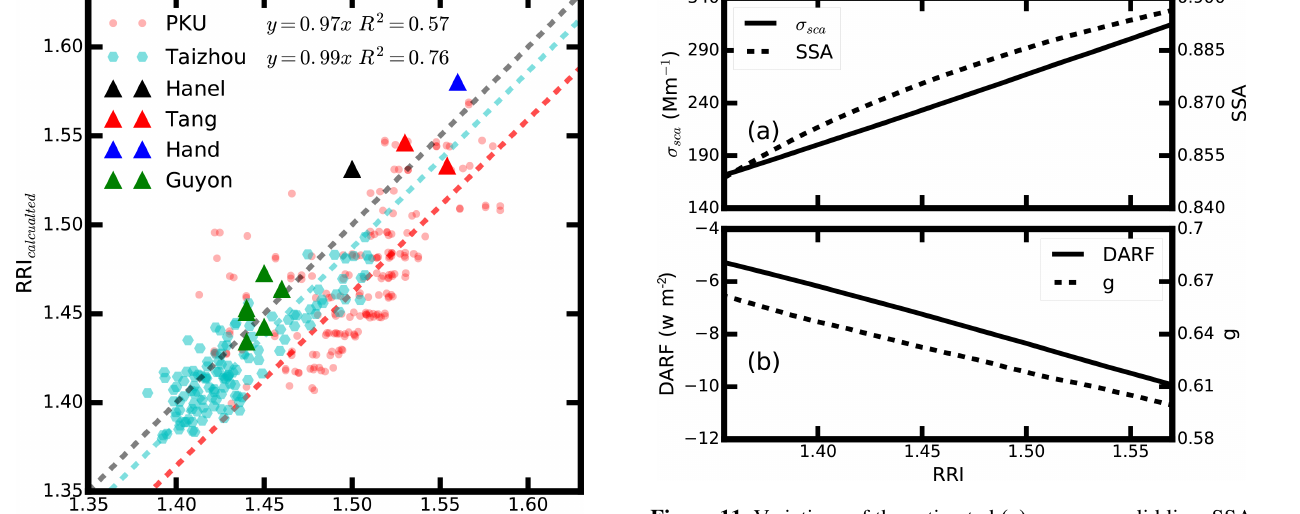
Figure 11. Variations of the estimated (a) σ sca as a solid line, SSA as a dotted line, (b) g as a dotted line and DARF as a solid line for different aerosol RRI